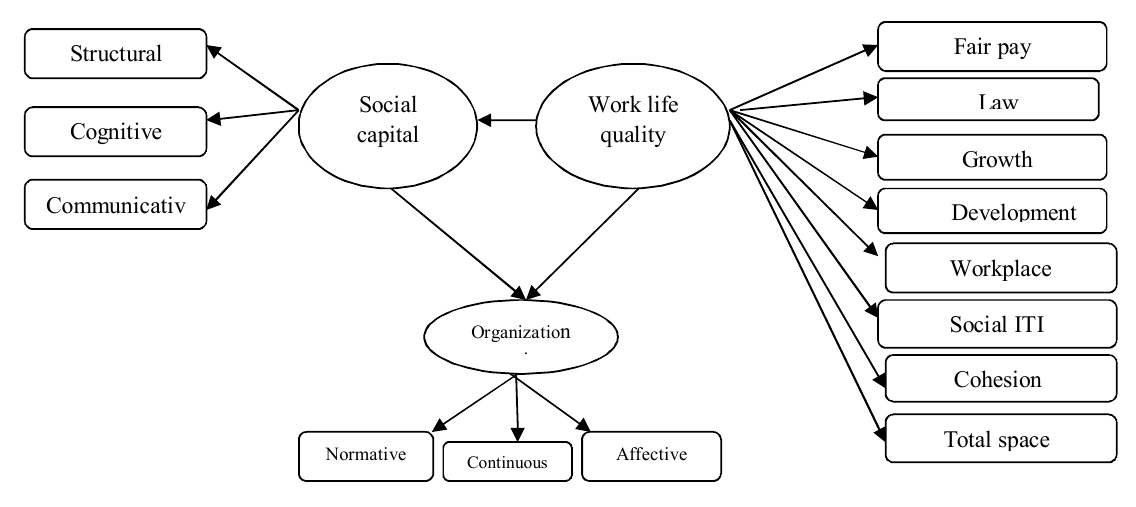
Fig. 1. The conceptual model of